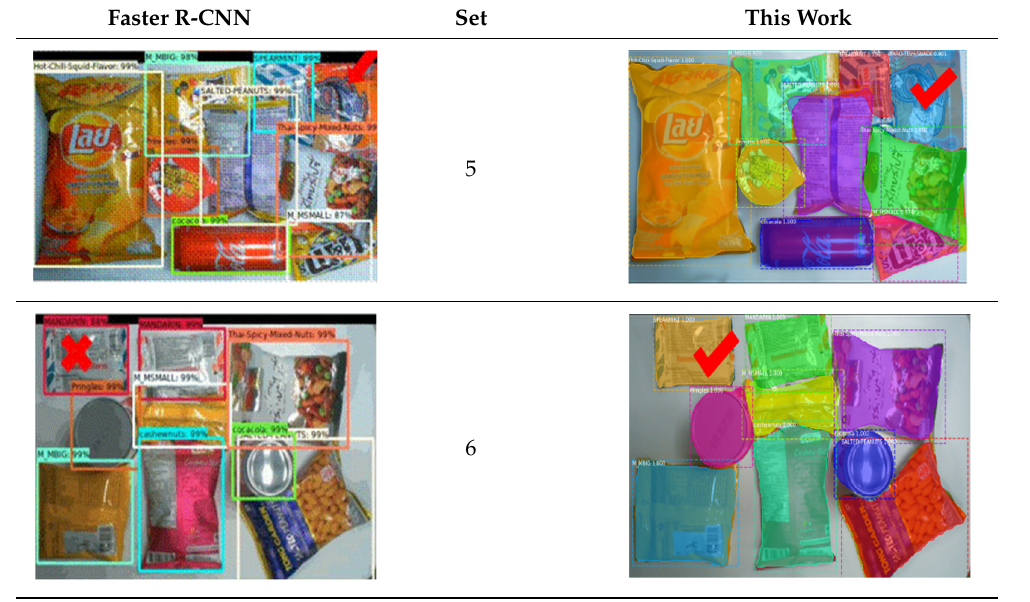
Table 8. Cont. Faster R-CNN Set This